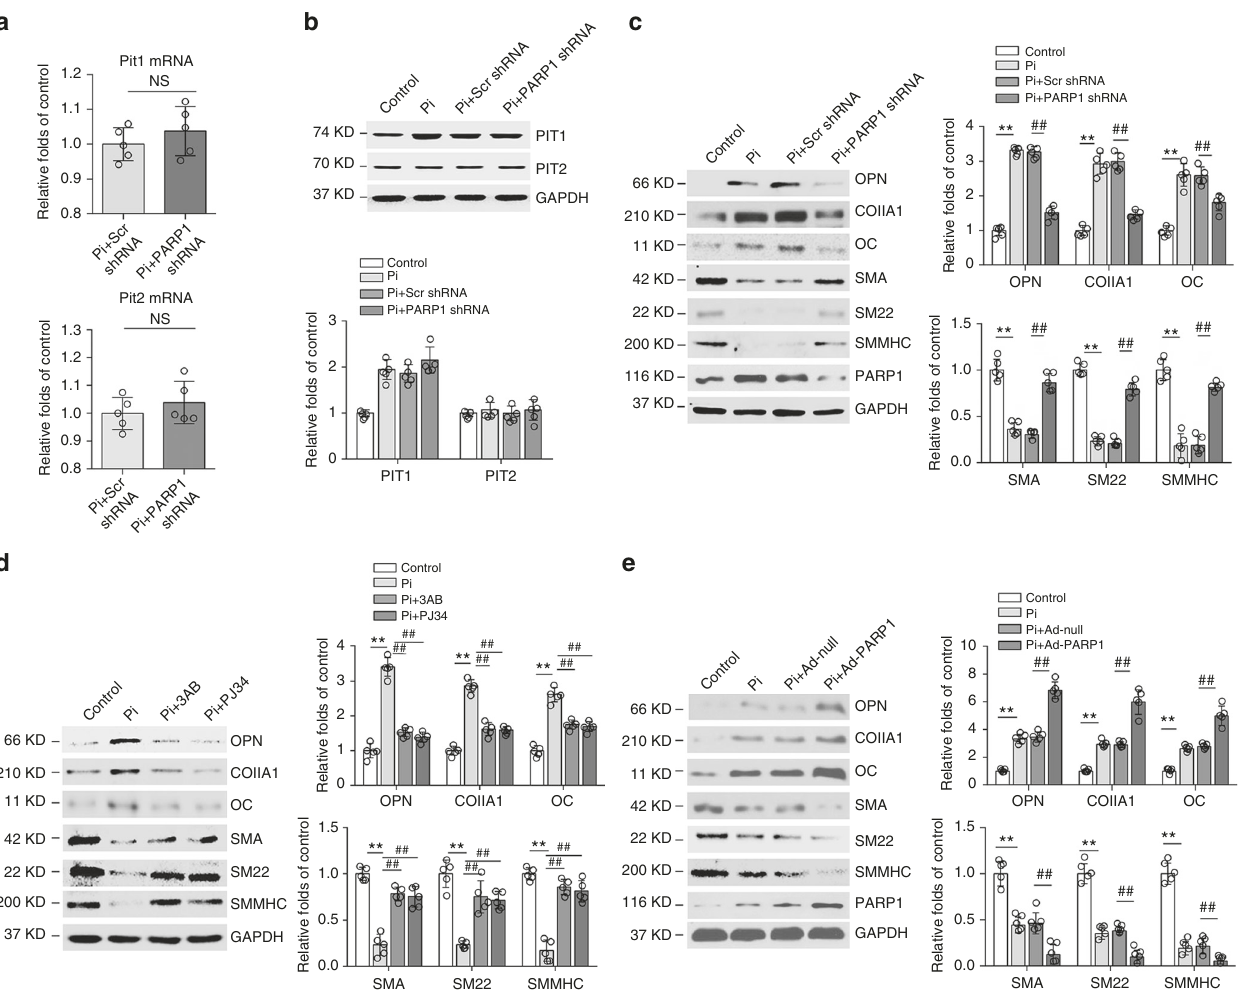
Fig. 3 PARP1 regulates VSMCs osteogenic transition, not Na/P co-transporter. a , b Quantitative RT-PCR ( a ) and western blot ( b ) analysis of PIT1 and PIT2 expression in VSMCs, which were infected with Scrambled (Scr shRNA) or PARP1 shRNA, and treated with high Pi. c – e Rat VSMCs were infected with adenovirus carrying Scr shRNA, PARP1 shRNA, Null or PARP1 gene for 48 h and then incubated with osteogenic media for 14 days. PARP1 inhibitors 3AB (10 mM) and PJ34 (10 μ M) were added every day. Western blot analysis and related quanti fi cation of osteogenic-related marker genes (OPN, ColIA1, and OC) and smooth muscle marker genes (SMA, SM22 and SMMHC) expression in VSMCs with PARP1 knockdown ( c ), PARP1 inhibitors 3AB and PJ34 ( d ), and PARP1 overexpression ( e ). ( n = 5 for each group). Statistical signi fi cance was assessed using one-way ANOVA for multiple comparison and two-tailed t -tests for two groups and is presented as follows: NS: no signi fi cance, ** P < 0.01 and ## P < 0.01. All values are means±